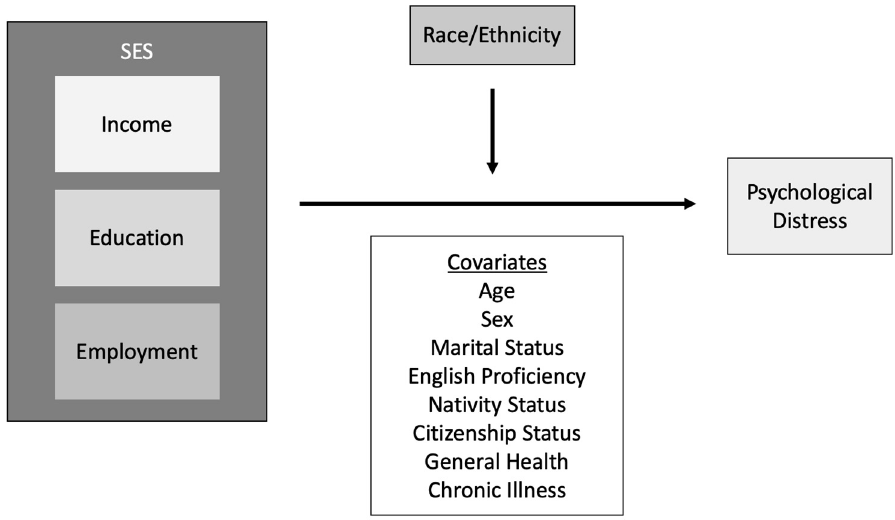
Figure 1. Conceptual Model for SES and Psychological